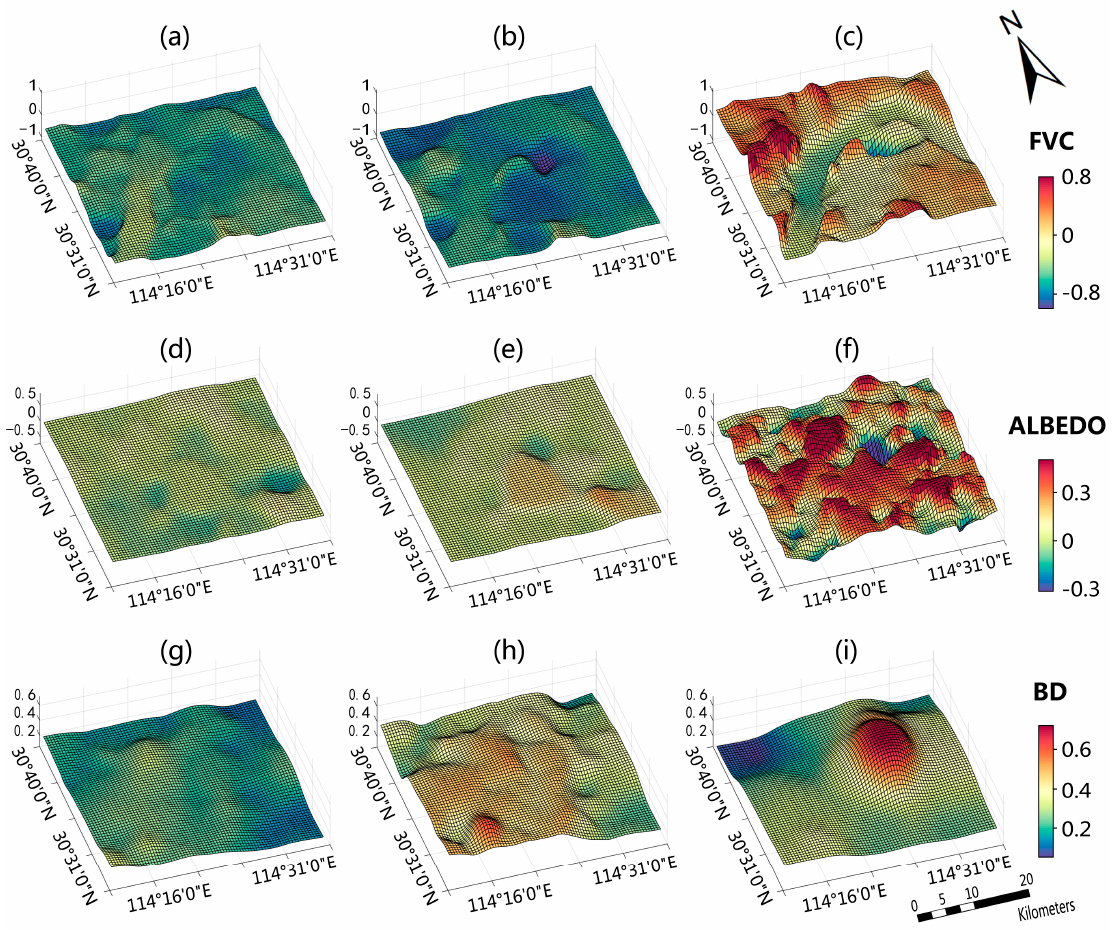
Figure 7. The spatial non-stationary slope coefficients of the indicators. ( a – c ) Slope coefficients of FVC in summer, the transition season and winter, respectively; ( d – f ) albedo; and ( g – i ) BD.